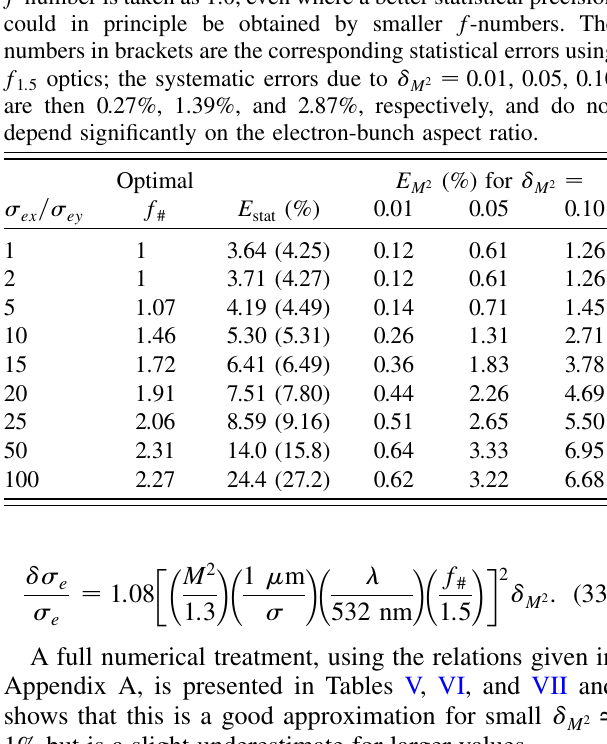
TABLE VII. Optimal f -numbers (for E and the corresponding statistical precision for (cid:2) ment of (cid:2) ey 1 (cid:3)m , (cid:13) (cid:1) 266 nm , and M 2 (cid:1) 1 : 3 . The minimum practical f -number is taken as 1.0, even where a better statistical precision could in principle be obtained by smaller f -numbers. The